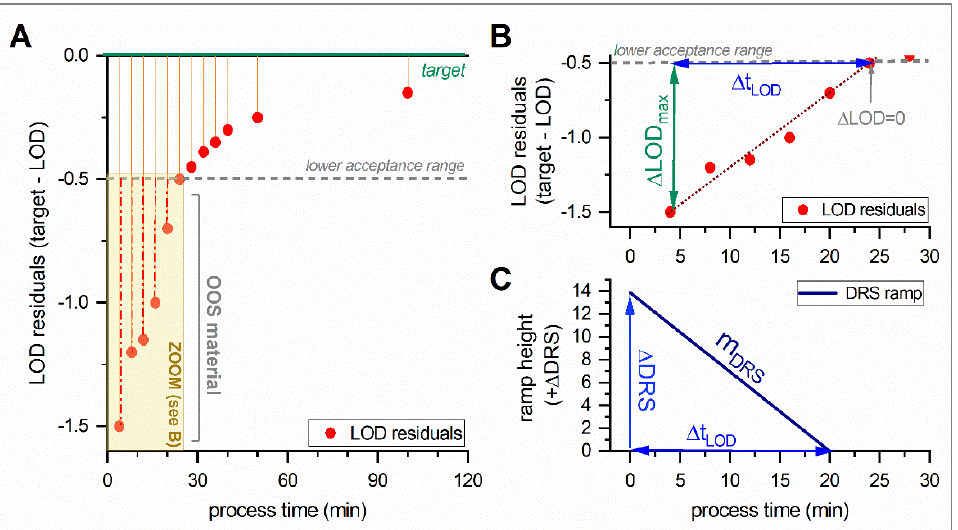
Figure 2. Detailed description on ramp height and slope calculation. ( A ) loss-on-drying (LOD) residuals of an arbitrary example data set; ( B ) Zoom in the out-of-specification (OOS) data from A; ( C ) the slope of the OOS residuals approaching the lower acceptance range allows to calculate the slope of the dryer rotation speed (DRS) ramp, according to Equations (3) and (4).